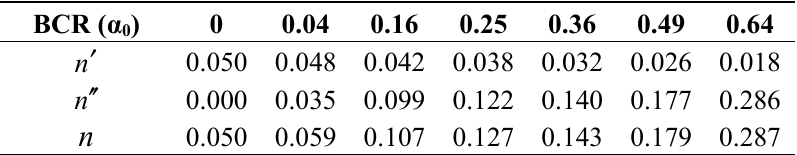
Table 3. Roughness under different BCRs.